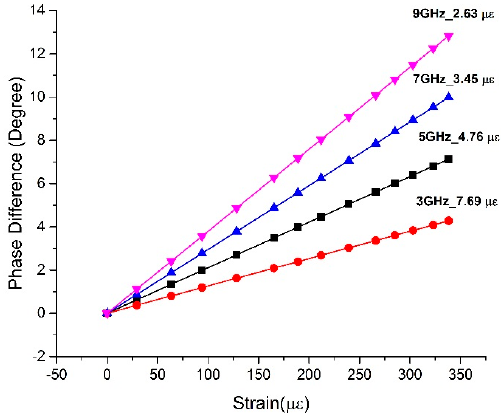
Figure 11. The strain sensitivity of a sensor working at different frequencies.